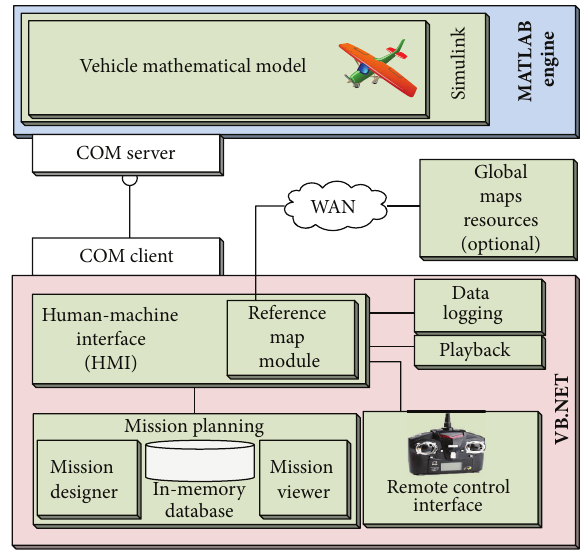
Figure 1: Hybrid simulator block